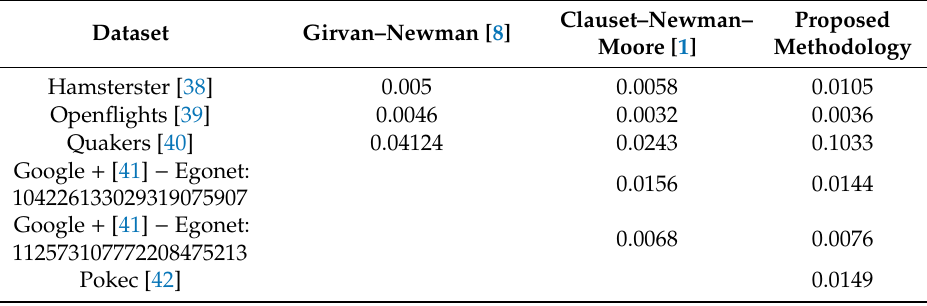
Table 4. Average generated community density [44].